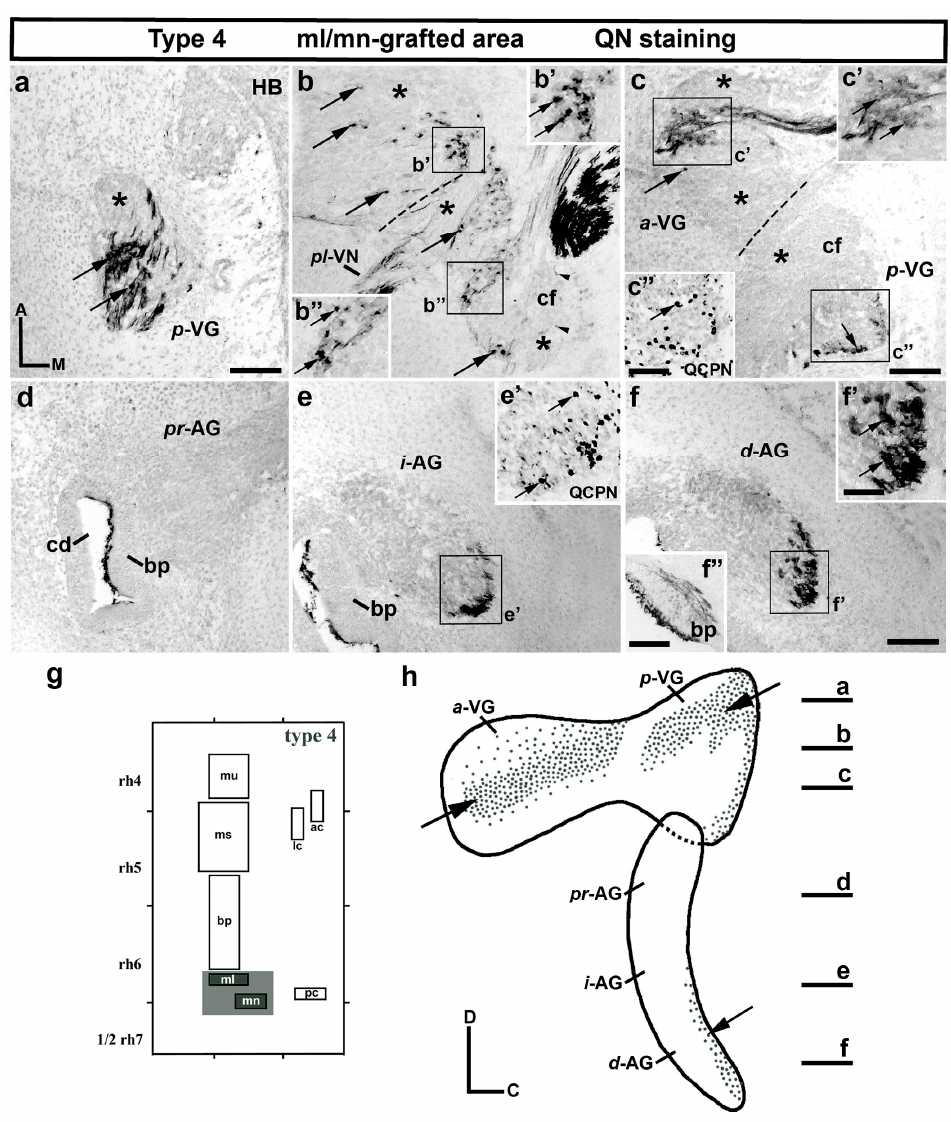
Figure 4. Graft-derived quail ganglionic neurons from the extended area of the macula lagena and macula neglecta (type-4 grafts; n = 8). ( a – f ) Horizontal sections through the vestibular ( a – c ) and acoustic ( d – f ) ganglia. QN-stained neurons were detected in the vestibular ganglion ( a -VG and p -VG; arrows in ( a – c (cid:48)(cid:48) )). ( a – c ) The asterisks indicate the portions of the VG devoid of quail grafted neurons. In the AG, quail-grafted neurons were found in the periphery of the intermediate and distal subdivisions ( i -AG and d -AG; arrows in ( e (cid:48) , f (cid:48) )). Inserts ( c (cid:48)(cid:48) , e (cid:48) ) confirm the presence of QCPN-stained neurons in the p -VG and i -AG, respectively. Note that the proximal pr -AG was completely devoid of QN-positive neurons ( d ). The arrowheads in b point to a few axons in the cochlear fascicle (cf). ( g ) Schematic representation of type-4 grafts, considering the expanded sensory area of the macula lagena and macula neglecta (ml and mn; dark and light grey areas). ( h ) Diagram summarizing all these results, in which horizontal sections are indicated. The arrows point to the most significant accumulations of ml/mn-grafted neurons. Orientation: A, anterior; C, caudal; D, dorsal; M, Medial. Additional abbreviations: pl -VN, posterolateral vestibular nerve; bp, basilar papilla; cd, cochlear duct; HB, hindbrain. Scale bar = 16 µ m in ( a ); 32 µ m in ( b , c ); 11 µ m in ( b (cid:48) , b (cid:48)(cid:48) , c (cid:48) , c (cid:48)(cid:48) ); 19 µ m in ( d – f ); 8 µ m in ( e (cid:48) , f (cid:48) ); 16 µ m in ( f (cid:48)(cid:48)